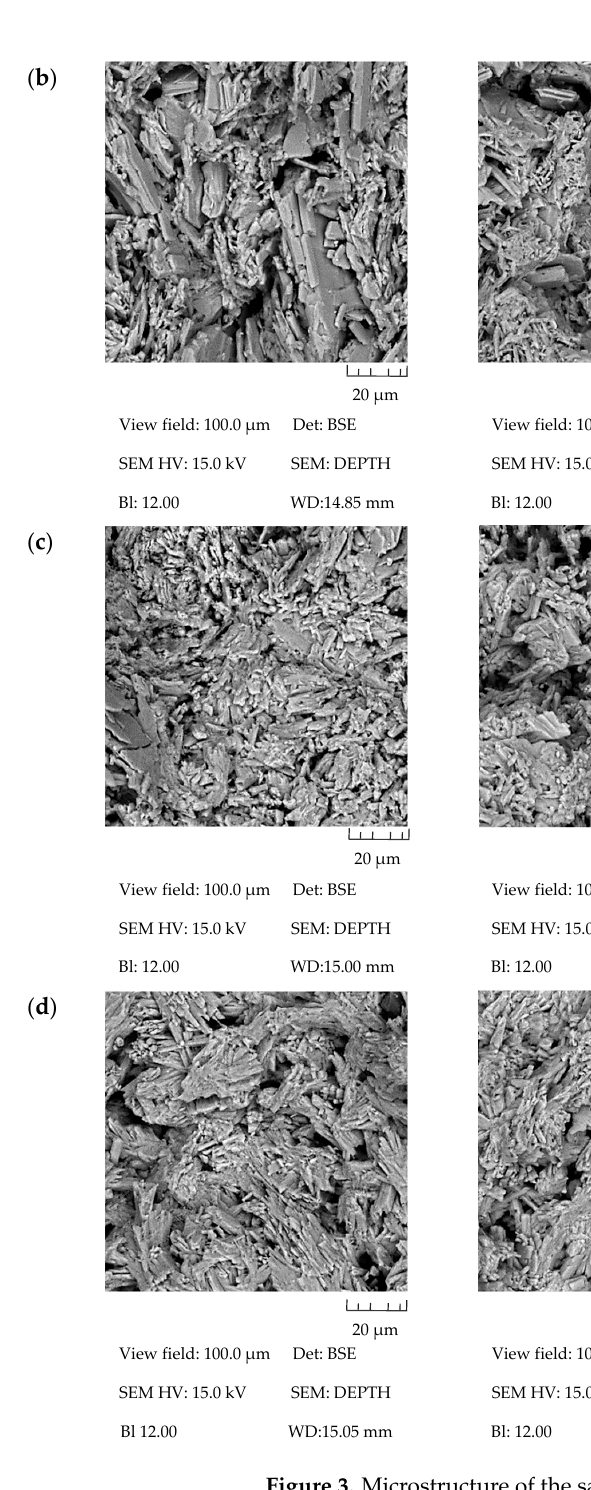
Figure 3. Microstructure of the samples at two days after demolding, depending on the mix design and molding pressure: ( a ) FCG content is 50%, by wt. ( Х 1 = +1); ( b ) FCG content is 30%, by wt. ( Х 1 = 0); ( c ) FCG content is 10%, by wt. ( Х 1 = − 1); ( d ) reference (FCG content is 0%). ( I )—molding pressure is 3 MPa (X 2 = − 1); W/S ratio is 0.15 (X 3 = − 1). (II )—molding pressure is 5 MPa ( Х 2 = 0); W/S ratio is 0.20 (X 3 = 0). ( III )—molding pressure is 7 MPa ( Х 2 = +1); W/S ratio is 0.25 (X 3 = +1).